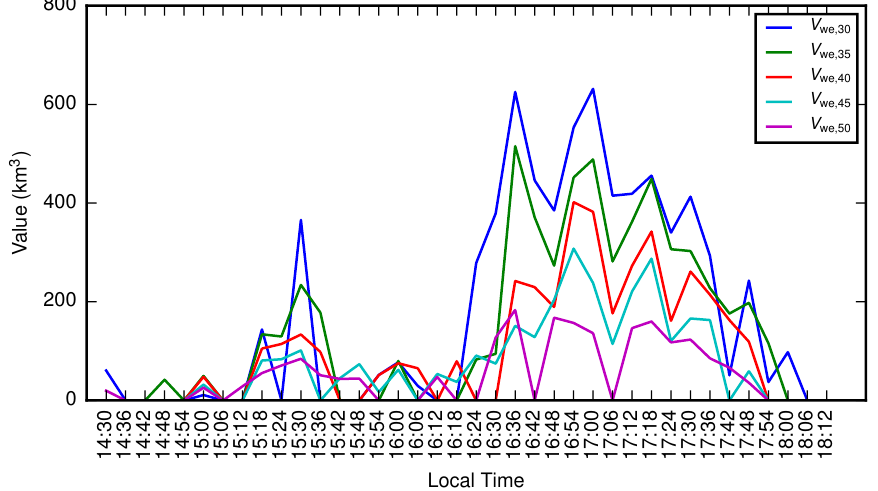
Figure 17. Changes of V we, R